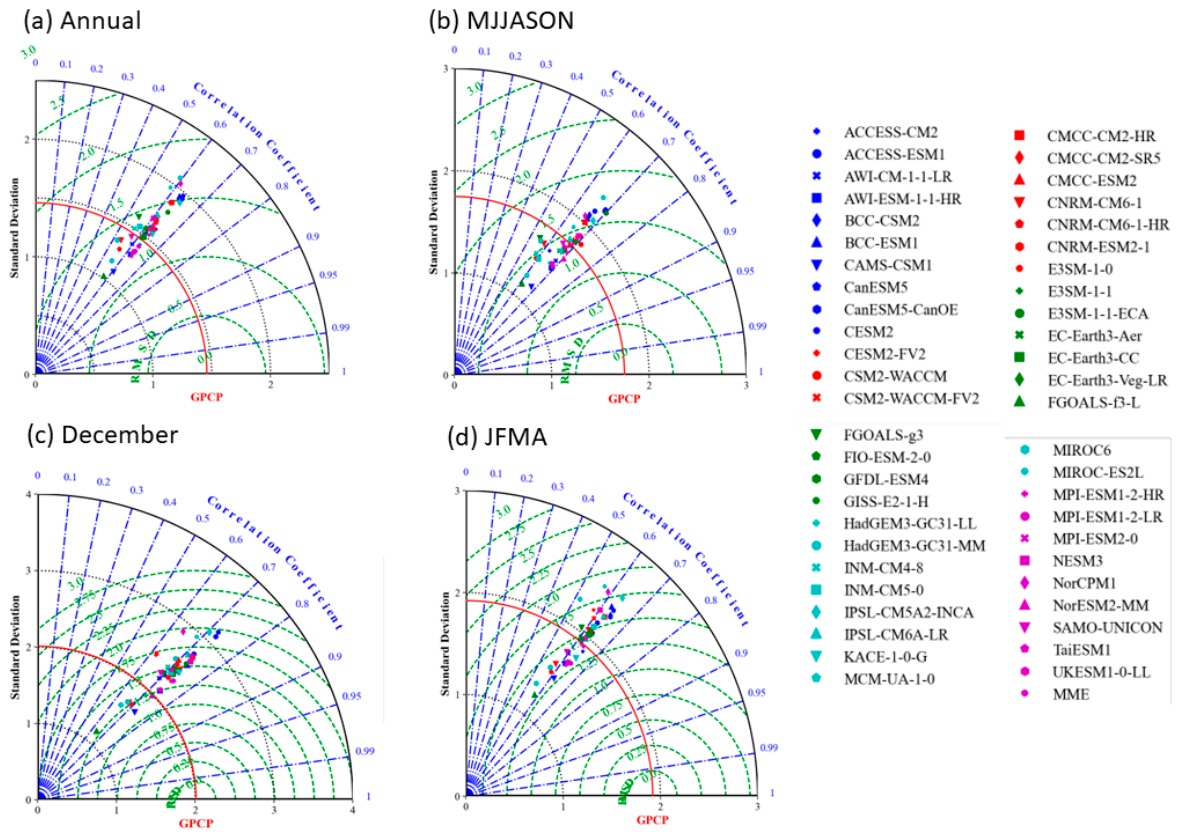
Figure 2. Taylor diagram comparing PREC observation (GPCP) with MME and 49 models (CMIP6) during 1980–2014. ( a ) Annual, ( b ) MJJASON, ( c ) December, ( d ) JFMA.